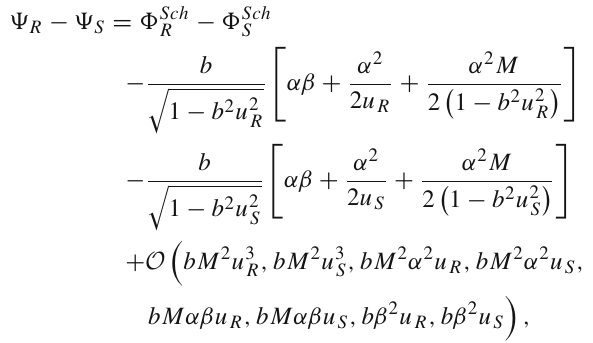
Fig. 6 Triangle embedded in the curved space M opt . Here, the point L denotes the lens center